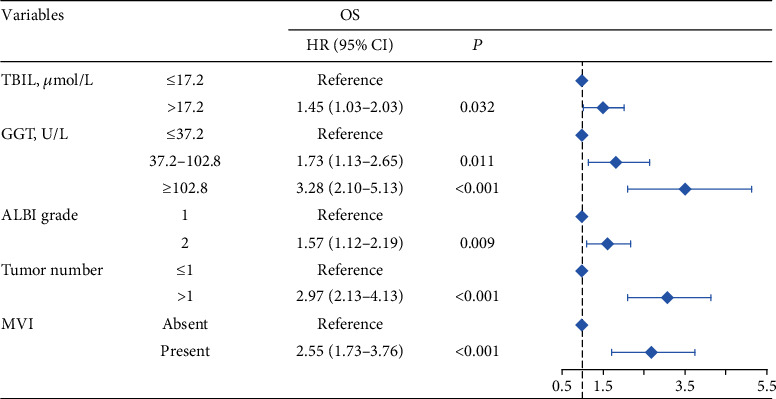
Multivariate analysis and forest plot of the hazard ratio of risk factors for overall survival. OS: overall survival; HR: hazard ratio; CI: confidence interval; TBIL: total bilirubin; GGT: gamma-glutamyltransferase; ALBI grade: albumin-bilirubin grade; MVI: microvascular invasion.